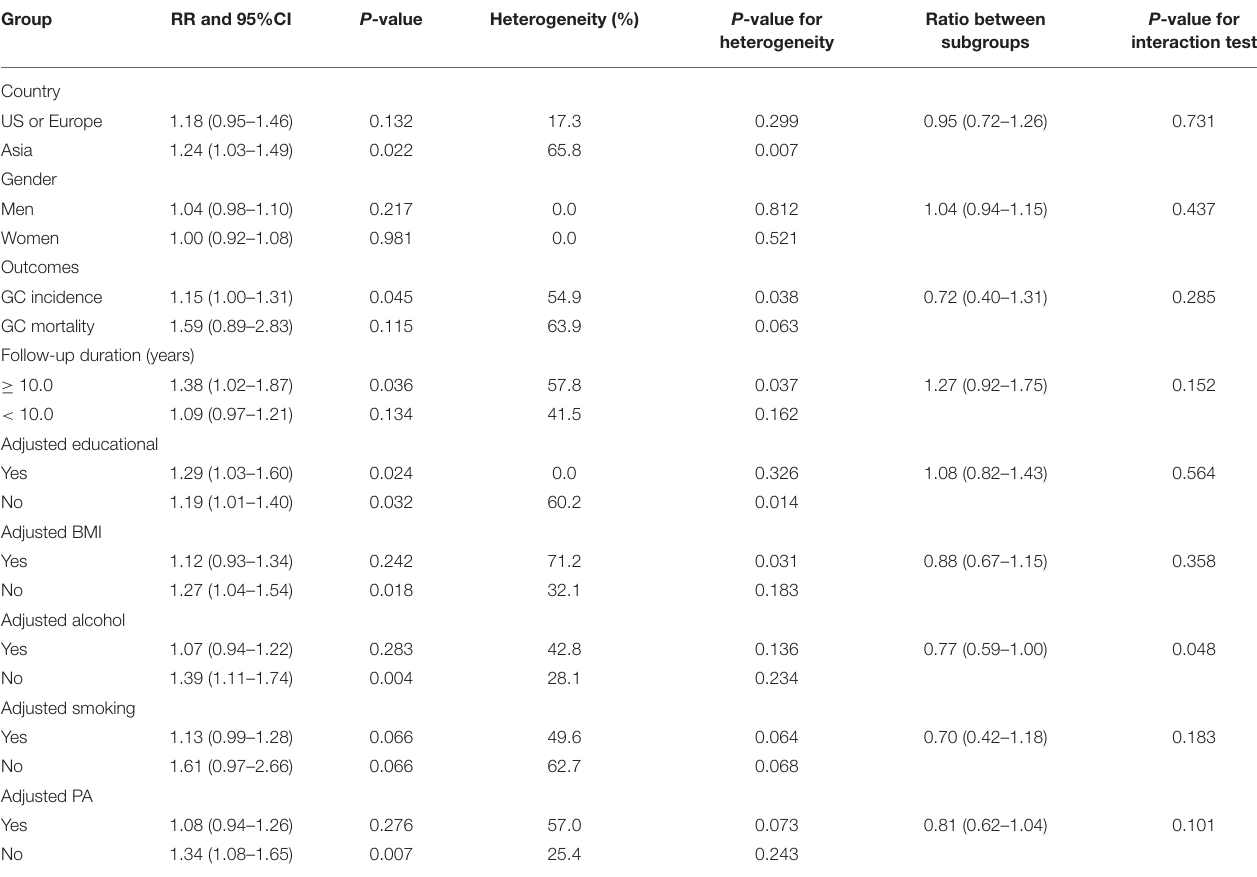
TABLE 3 | Subgroup analysis for moderate vs. low salt intake and the risk of gastric cancer. Group RR and 95%CI P -value Heterogeneity (%) P -value for